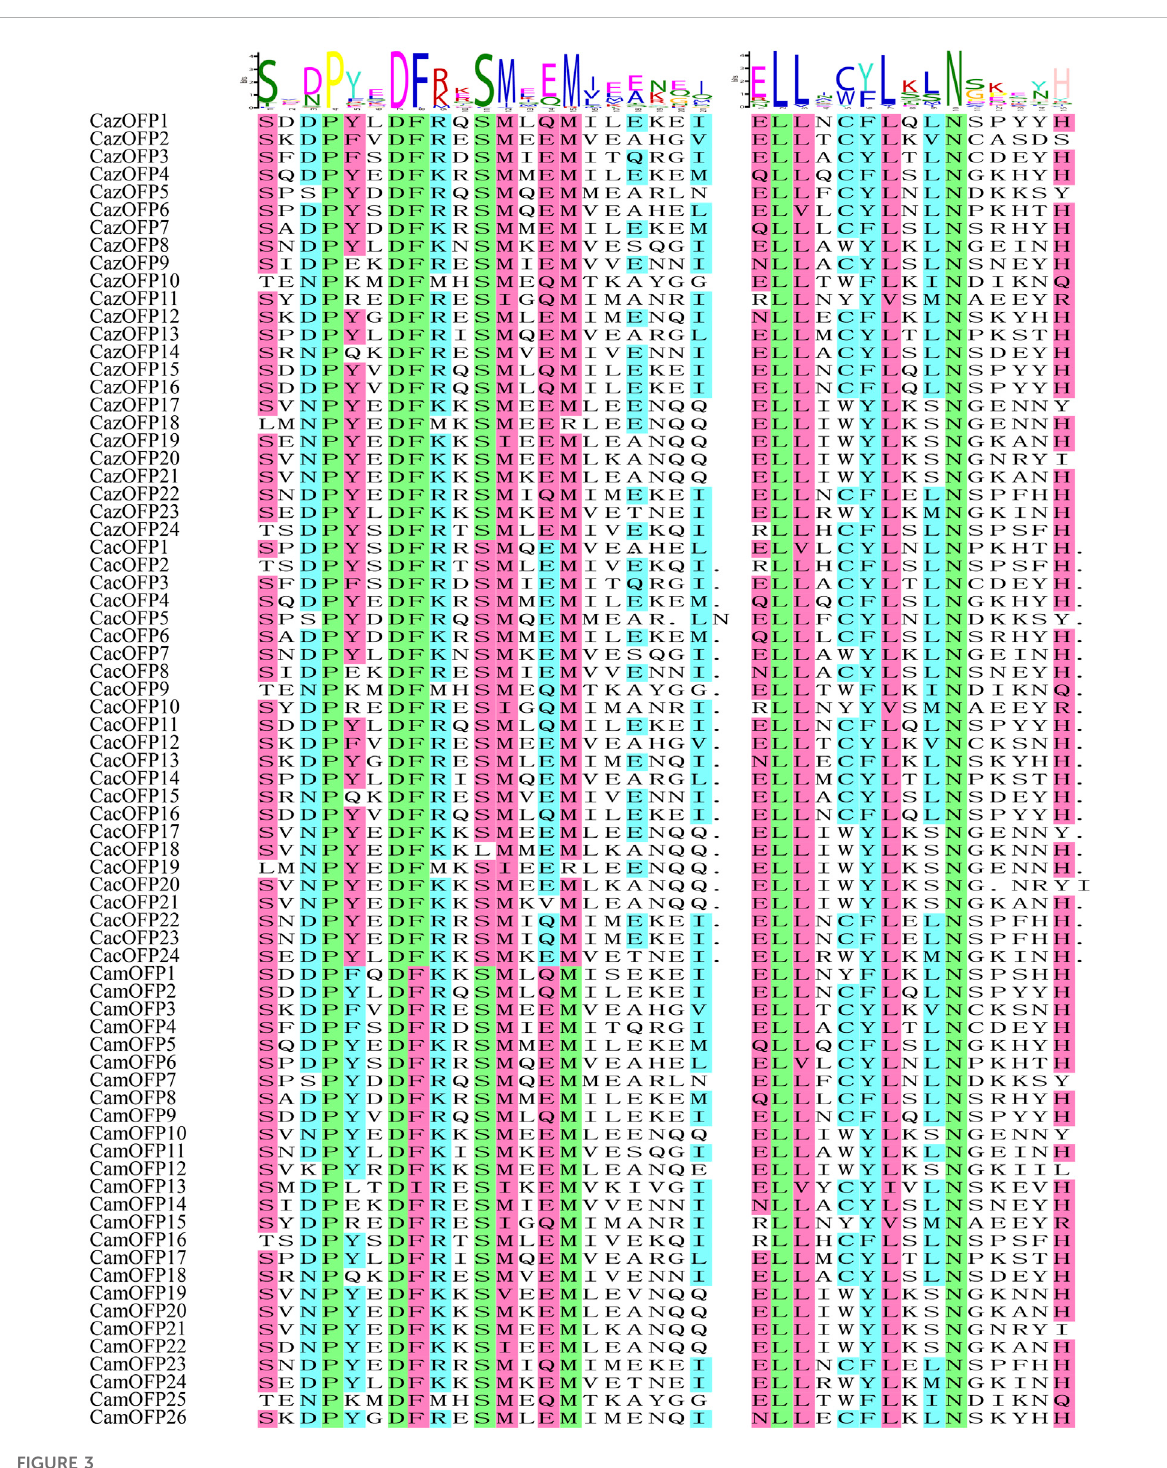
FIGURE 3 Sequence alignment of OFP transcription factor motifs in